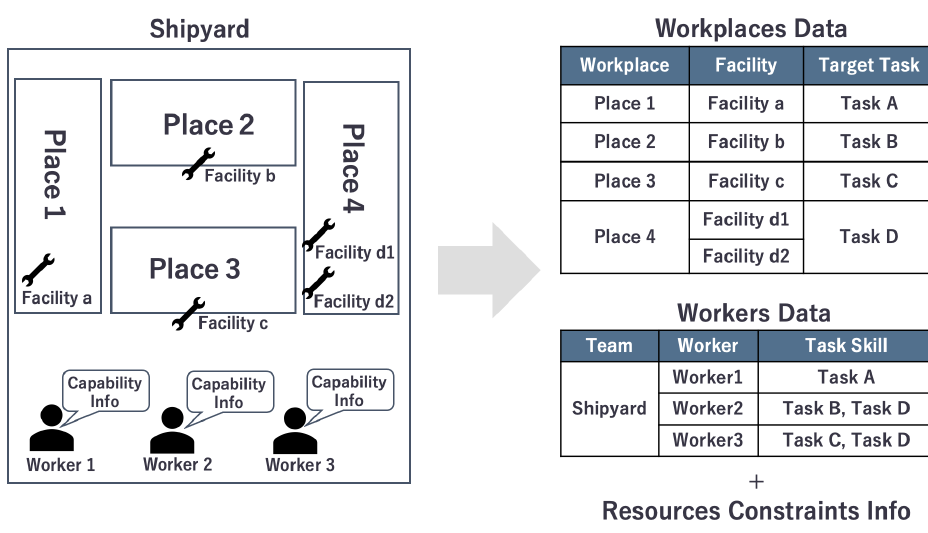
Figure 4. How to Create Workplace Data and Workers’ Data.